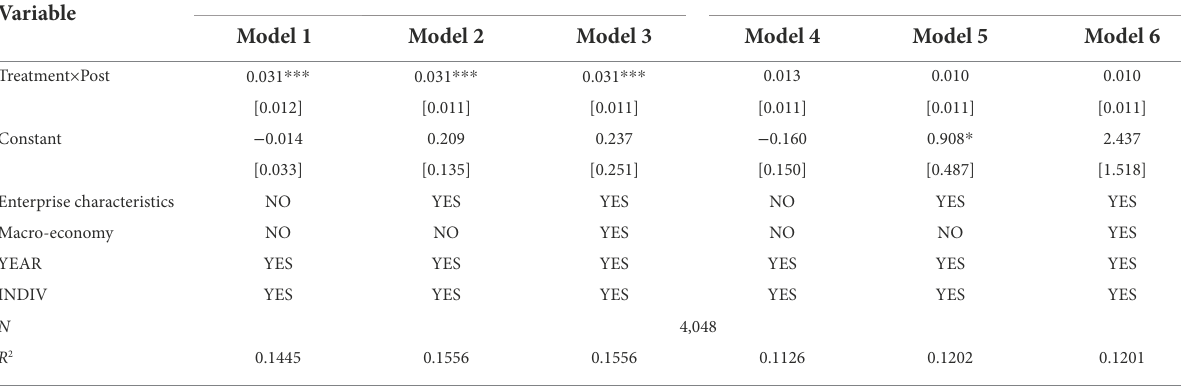
TABLE 6 Analysis with DID method after expanding the sample